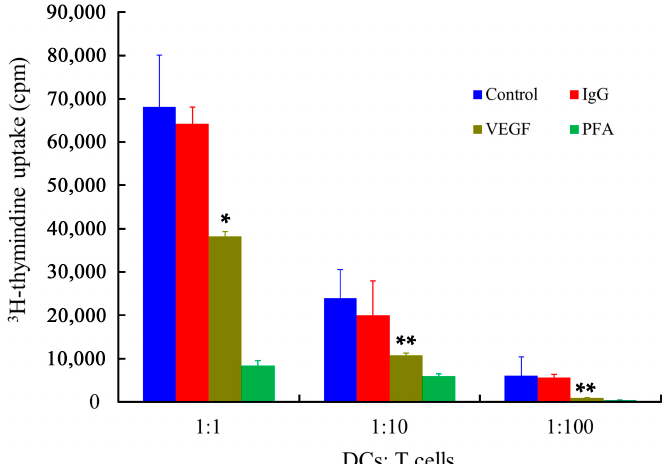
Figure 8. Effect of VEGF on the immune stimulatory capability of mDCs, as determined by MLR assay. The x -axis represents the ratio of cell numbers of mDCs to T cells. The y -axis represents the 3 H-thymidine radioactivity counts per minute in a MicroBeta TRILUX liquid scintillation counter. Compared with control group, * p < 0.05, ** p < 0.01.